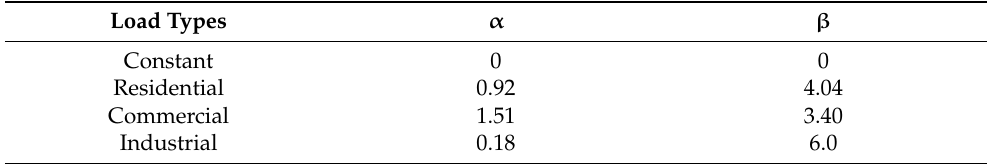
Table 2. Load types and exponent